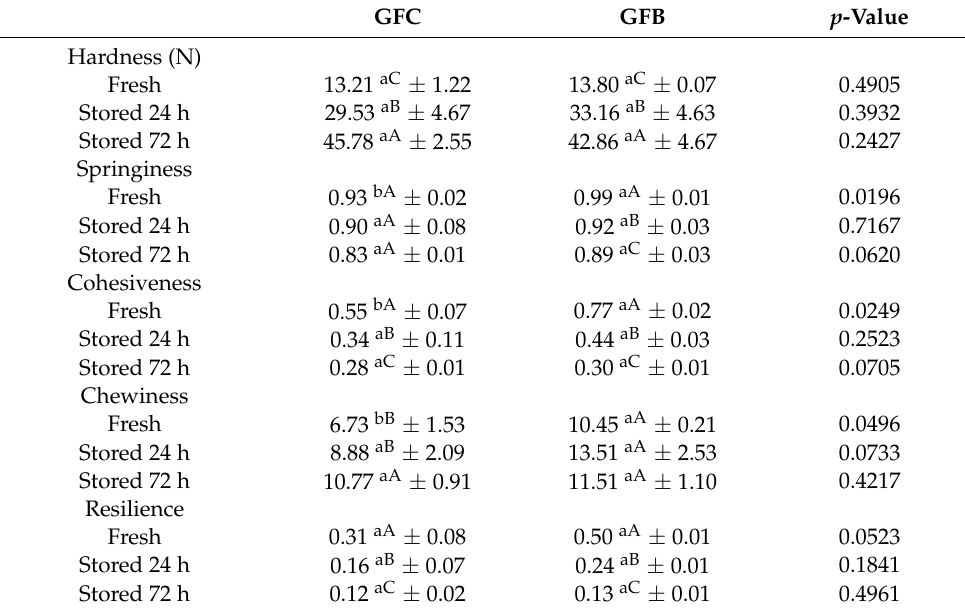
Table 4. Textural properties of fresh and stored experimental gluten-free